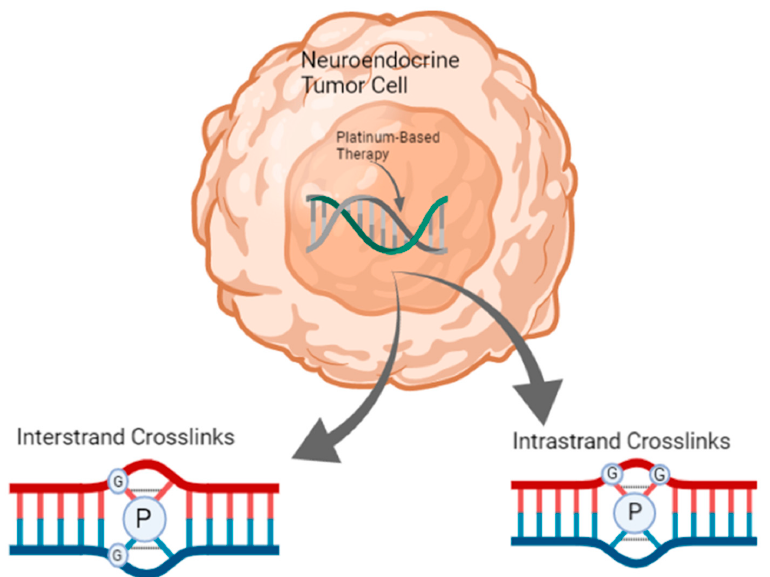
Figure 2. A depiction of the mechanism of action of platinum-based therapies (e.g., oxaliplatin, cis- platin, and carboplatin) in a neuroendocrine tumor. The platinum agent binds to the N 7 position of guanine to form inter-strand or intra-strand crosslinks, which stall DNA replication and cause cell death. The table was created in Biorender. Abbreviations: P, platinum agent; G, guanine. Pancreatic